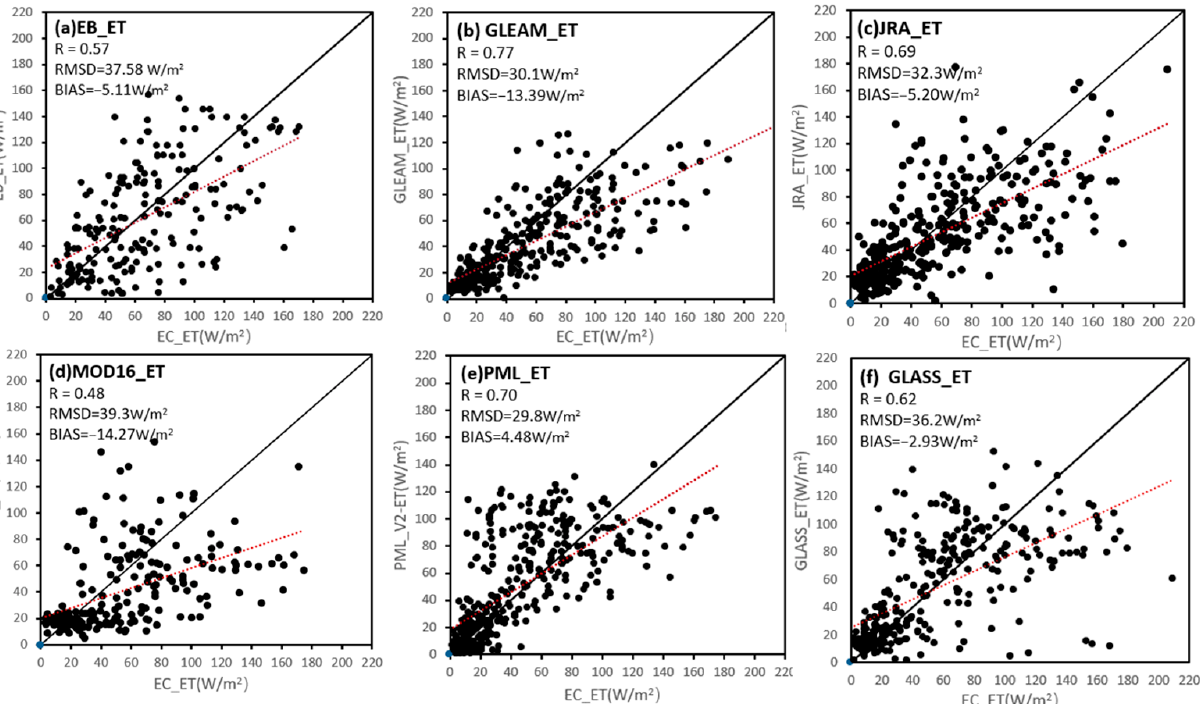
Figure 4. Analytical plots of the ET product data versus the EC observations: ( a ) EB_ET; ( b ) GLEAM_ET; ( c ) JRA_ET; ( d ) MOD16_ET; ( e ) PML_ET; ( f ) GLASS_ET.